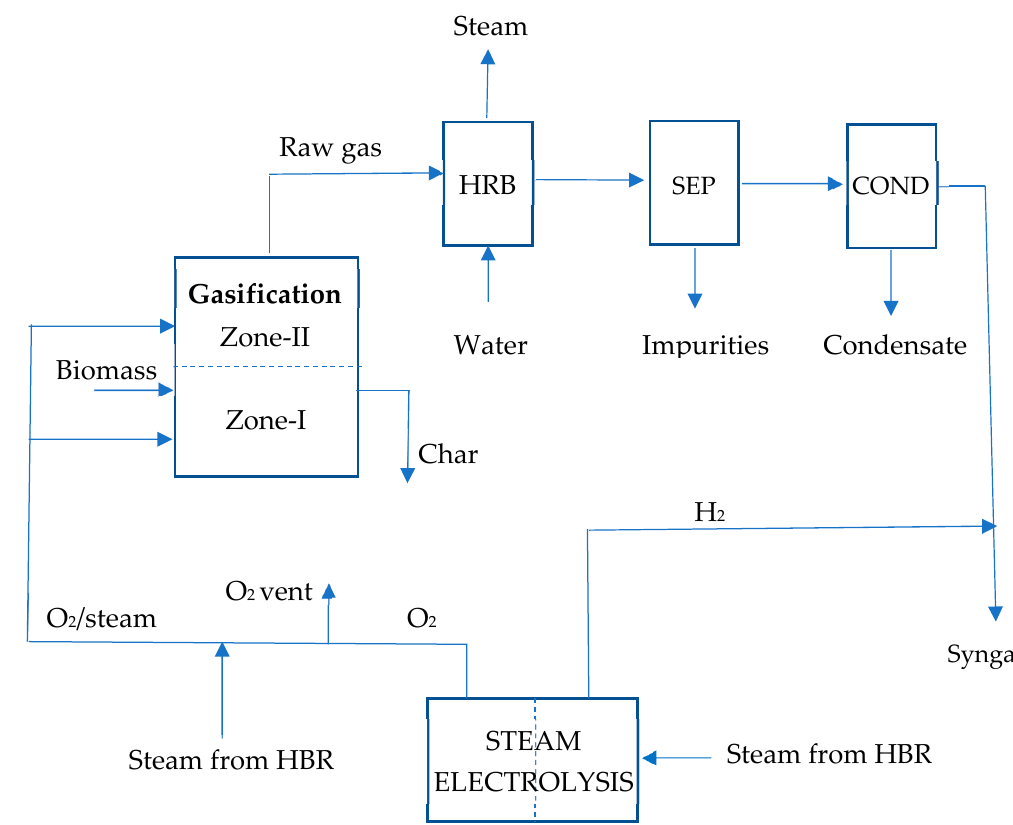
Figure 1. Schematic block diagram of a conceptual integration of water electrolysis with biomass